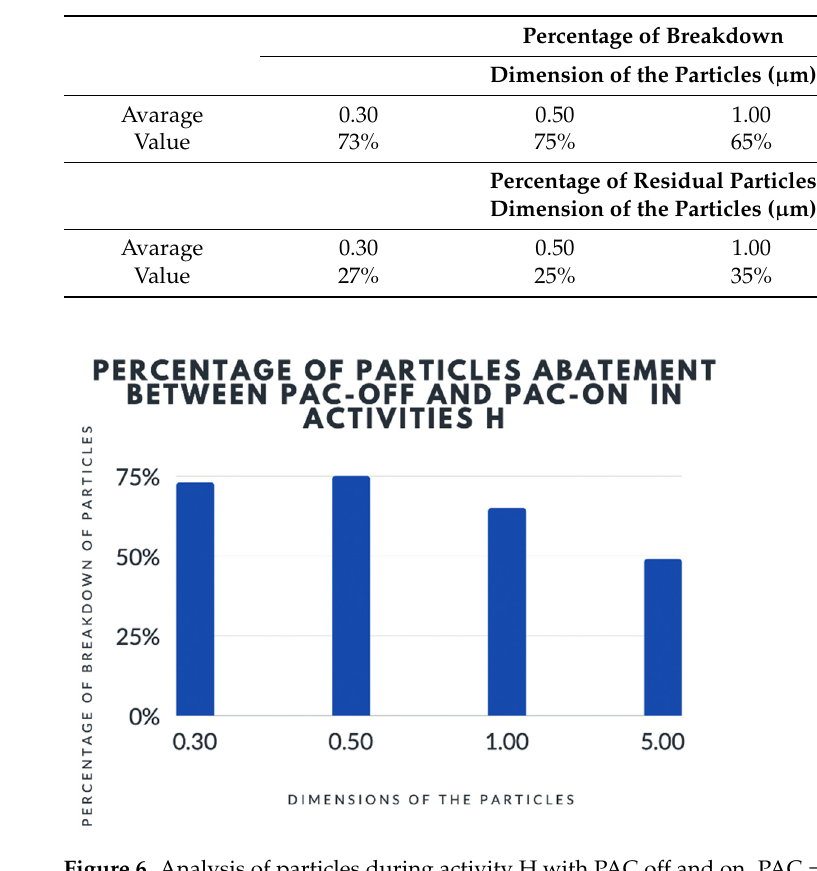
Table 2. Analysis of particles during activity S with PAC off and